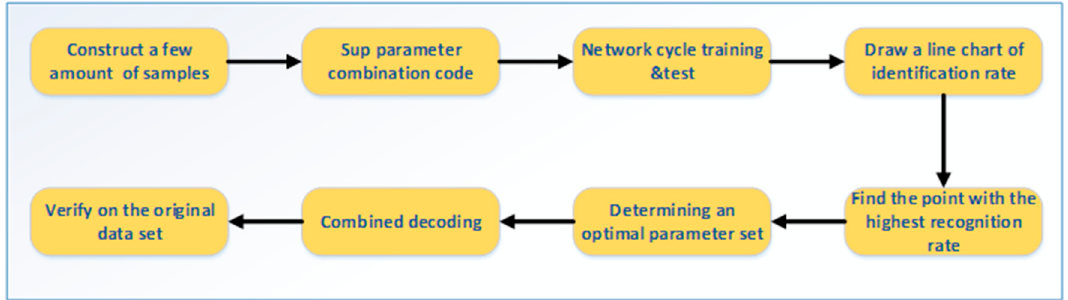
Figure 12. Small sample tuning parameters flow chart.